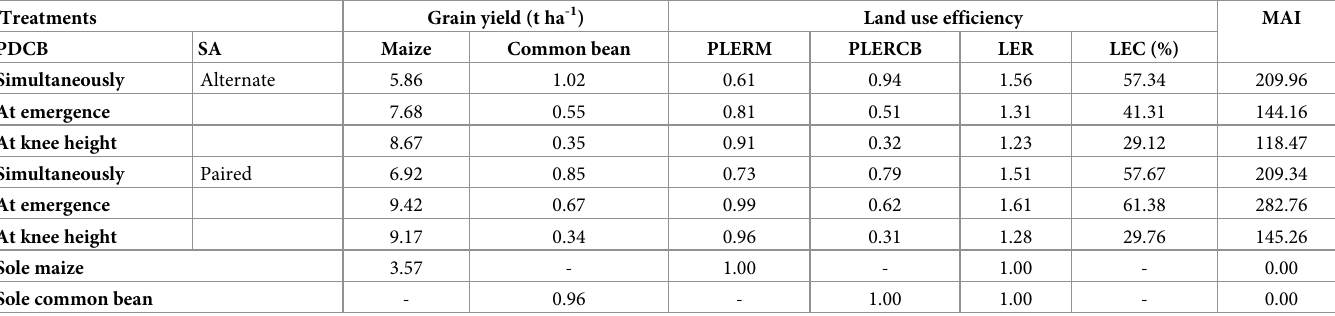
a Data was combined over years (2014 and 2016). PDCB, Planting date of common bean with maize in a mixture; SA, spatial arrangements of the component crops PLERM = partial land equivalent ratio of maize; PLERCB = partial land equivalent ratio of common bean; LER = land equivalent ratio; LEC = land equivalent coefficient; MAI = monetary advantage